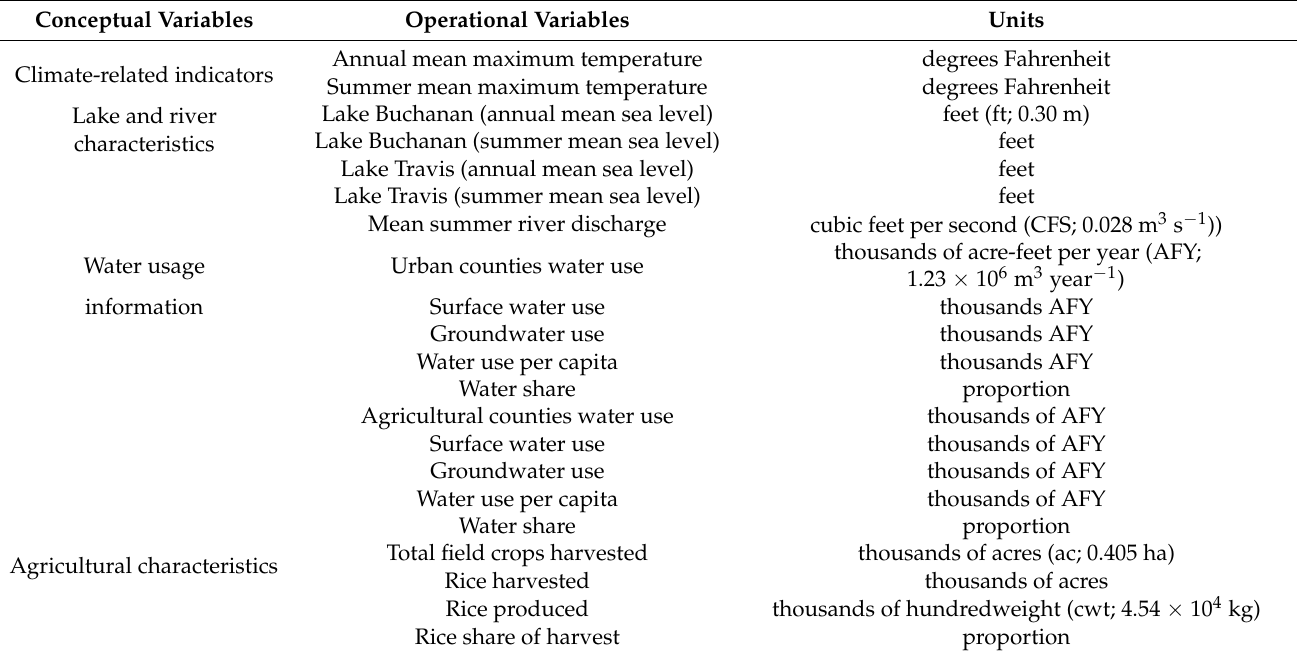
Table 1. List of conceptual and operational variables. Operational variables were converted to continuous annual time series described in Section